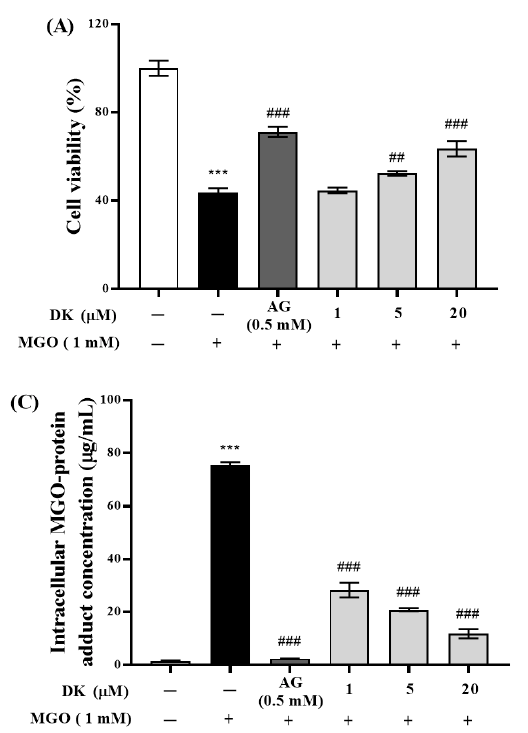
Figure 2. Preventive effect of DK against MGO-induced renal cell damage on mouse glomerular mesangial cells. It was confirmed through MTT assay that DK had no cytotoxicity up to a concen- tration of 20 μ M on mouse glomerular mesangial cells: ( A ) Renal cell protective effect of DK against MGO-induced oxidative stress induced was confirmed by MTT assay; ( B ) DCFH-DA assay was performed to evaluate the intracellular antioxidant activity of DK against intracellular oxidative stress induced by MGO treatment; ( C ) By measuring the intracellular MGO-protein adduct concen- tration, the inhibitory efficacy of DK on intracellular MGO accumulation was evaluated. All data are expressed as mean ± standard deviation ( n = 3) (*** p < 0.001 vs. nontreated cells and ## p < 0.01, ### p < 0.001 vs. MGO-treated cells).